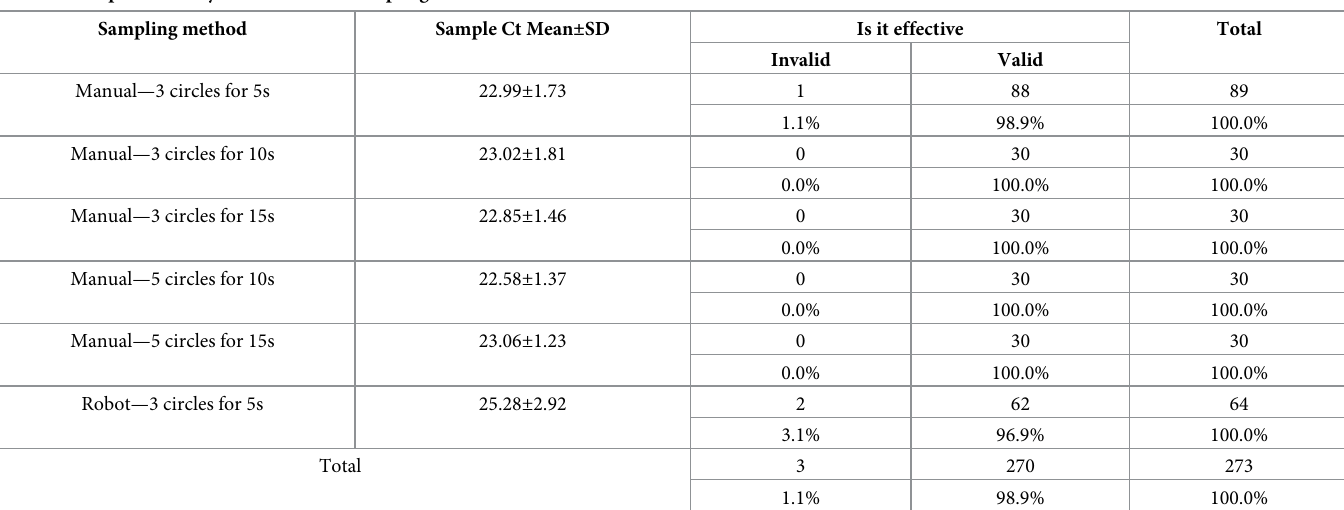
Table 4. Sample efficiency under different sampling